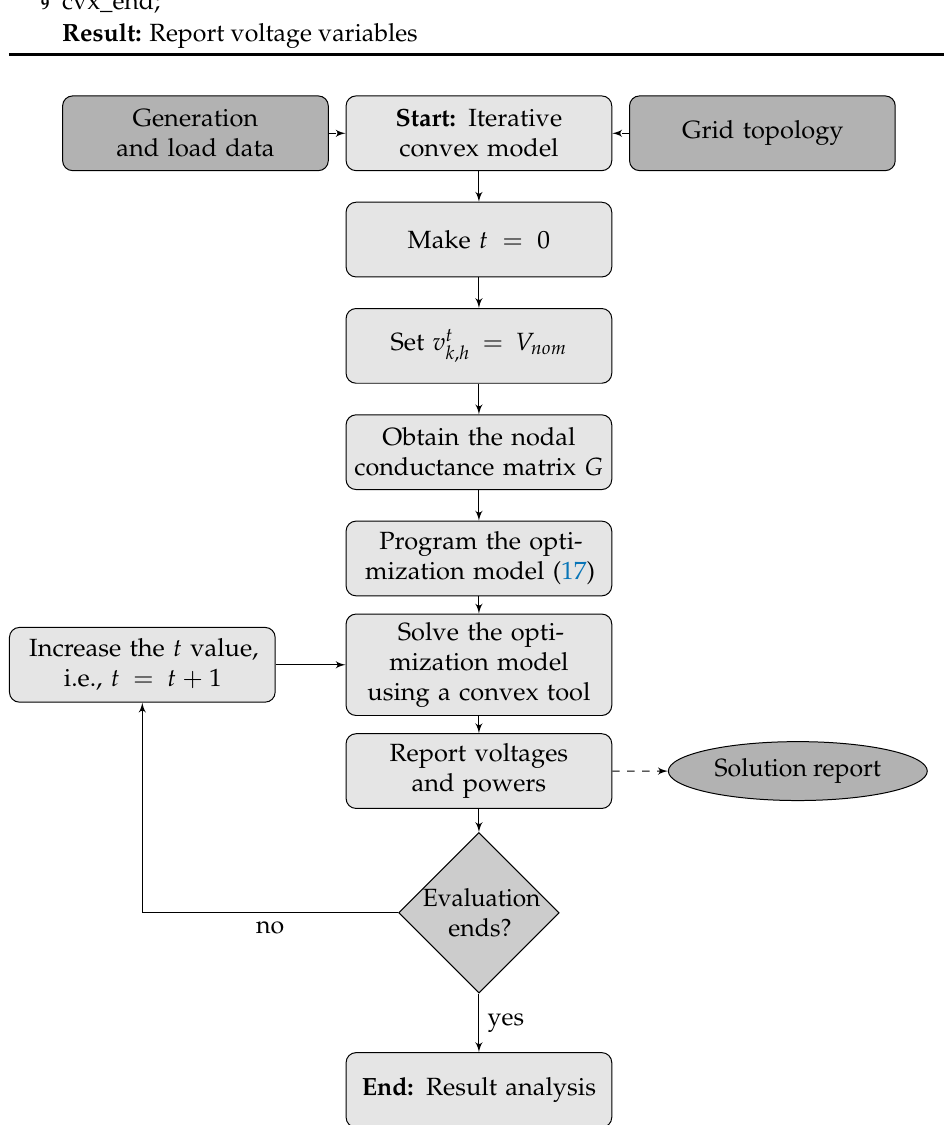
Figure 1. Iterative solution methodology for solving the optimization model